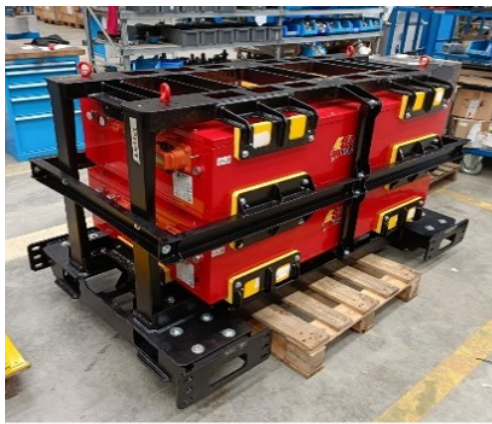
Figure 10. The battery system